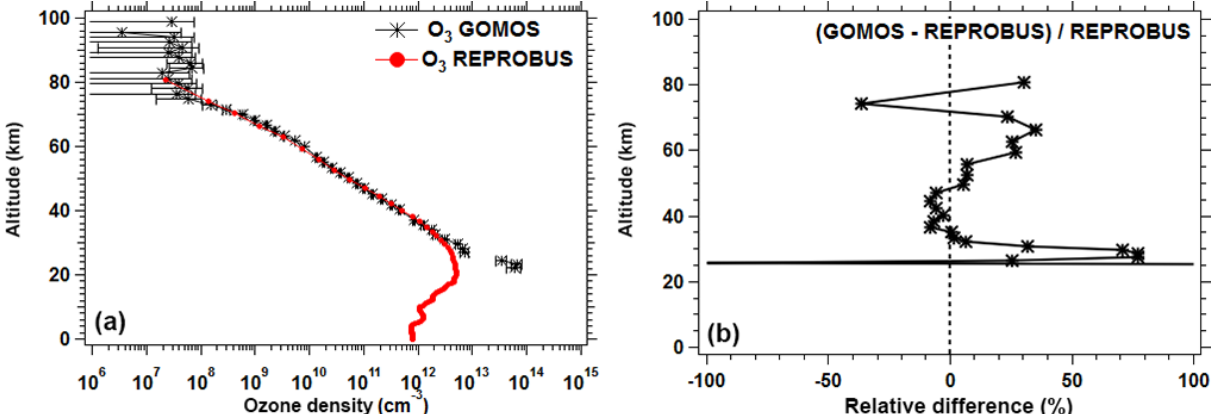
Figure C3. (a) One example of comparison of a GOMOS vertical dayside ozone profile (black curve) versus REPROBUS predic- tion (red curve). The GOMOS profile was observed on 5 August 2007, at an SZA of 38 ◦ . (b) Relative difference ( GOMOS − REPROBUS )/